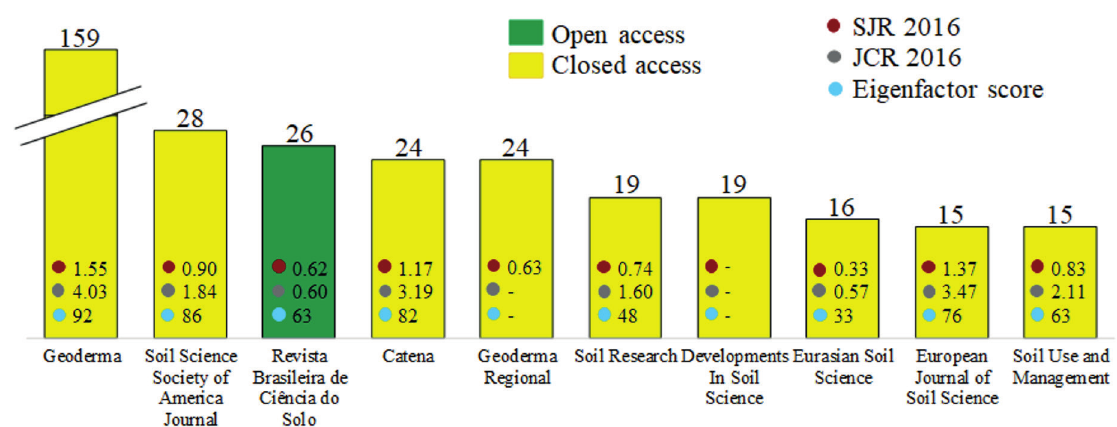
Figure 3 - Comparison of the 10 journals with highest output of DSM-related publications between 1996 and